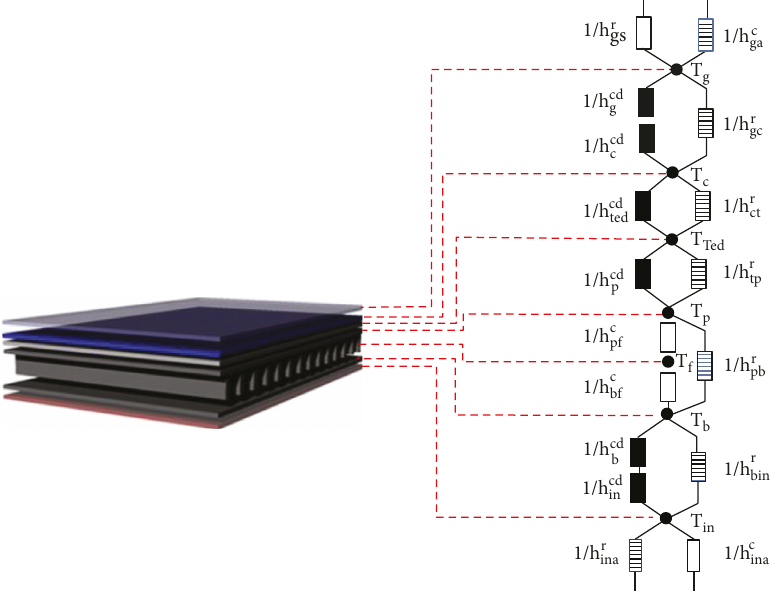
Figure 1: Photovoltaic thermal air